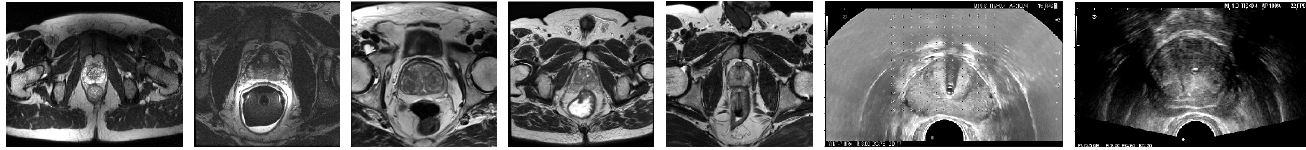
Figure 1. Center slice of a sample from MR and US datasets (from left to right): “Girona”, “Promise12”, “Prostate-3T”, “IVO (MR)”, “Private (MR)”, “IVO (US)” and “Private